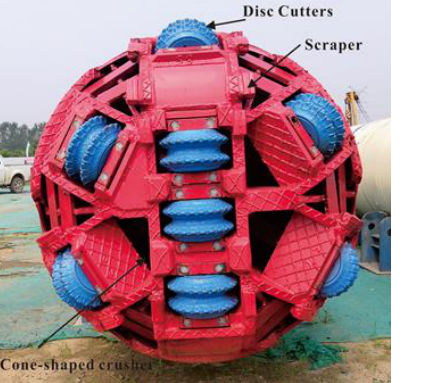
Figure 5. Layout form and modification of cutter head of the boring machine. Table 4. Specifications of the rapid laying and jacking machine.